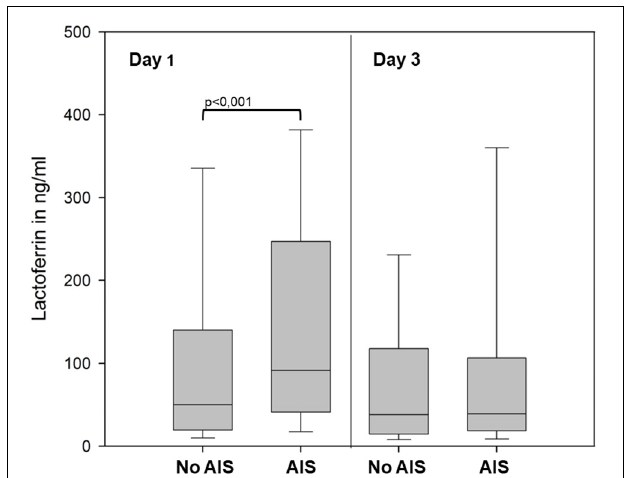
FIGURE 2 | LF levels in peripheral blood of preterm infants born with (AIS, n = 145) or without (No AIS, n = 96) signs of amnionic infection at days 1 and 3. Level of significance is marked above the brackets. Data is represented as box plot (median, 25th/75th, and 10th/90th percentiles).